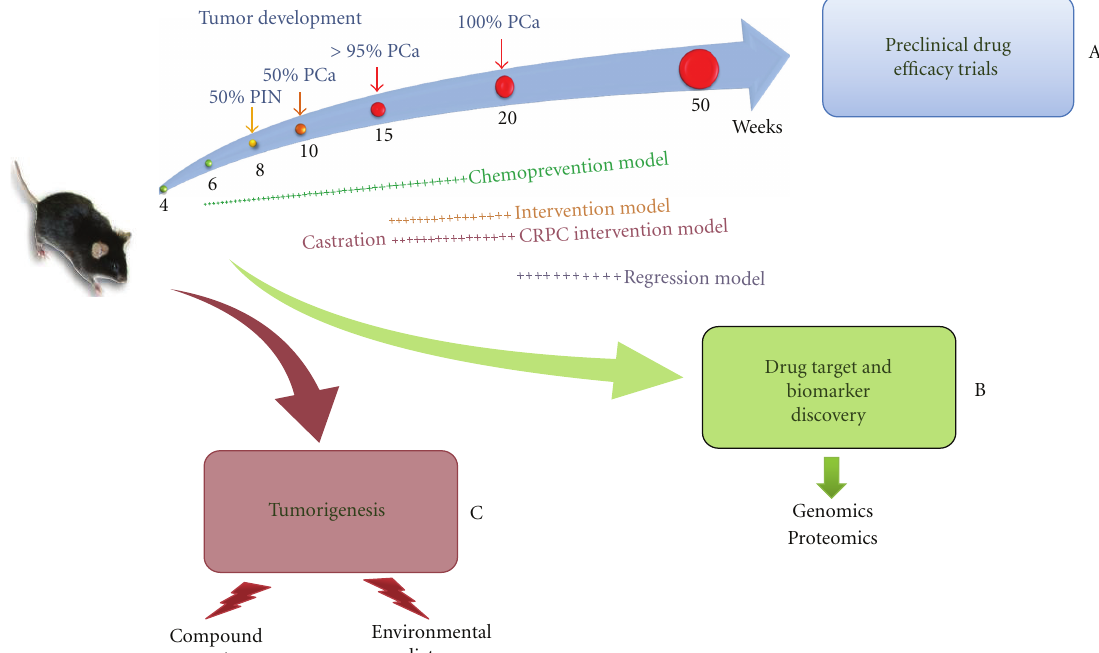
Figure 1: Modeling prostate cancer in the PTEN conditional knockout mouse model. (A) PSA Cre/ PTEN loxP/loxP can be used to screen for tumor response against targeted therapies in chemoprevention, intervention, or regression models using noncastrated or castrated mice. (B) Comprehensive genomic and proteomic analyses can be performed in PSA Cre/ PTEN loxP/ + , PSA Cre/ PTEN loxP/loxP , or bigenic mutants to identify candidate genes or proteins signatures aberrantly expressed between di ff erent pathologic, genomic, or temporal disease conditions. (C) Cooperation between genetic and nongenetic factors can be assessed in tumor development in both homozygous and heterozygous PTEN -conditional mutant